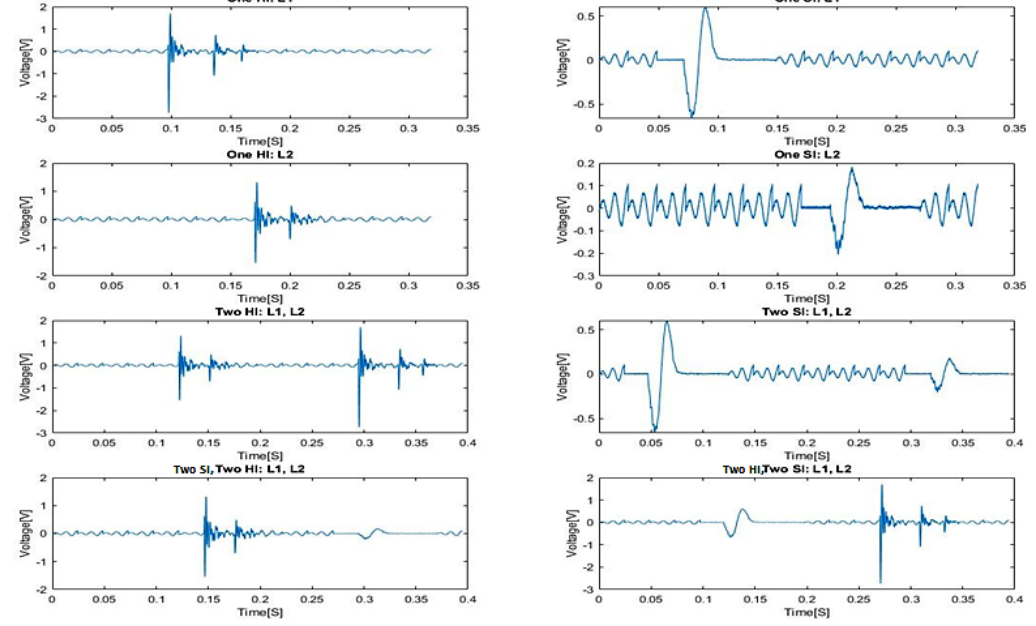
Figure 13. Examples of isolated impacts representing more realistic signals.